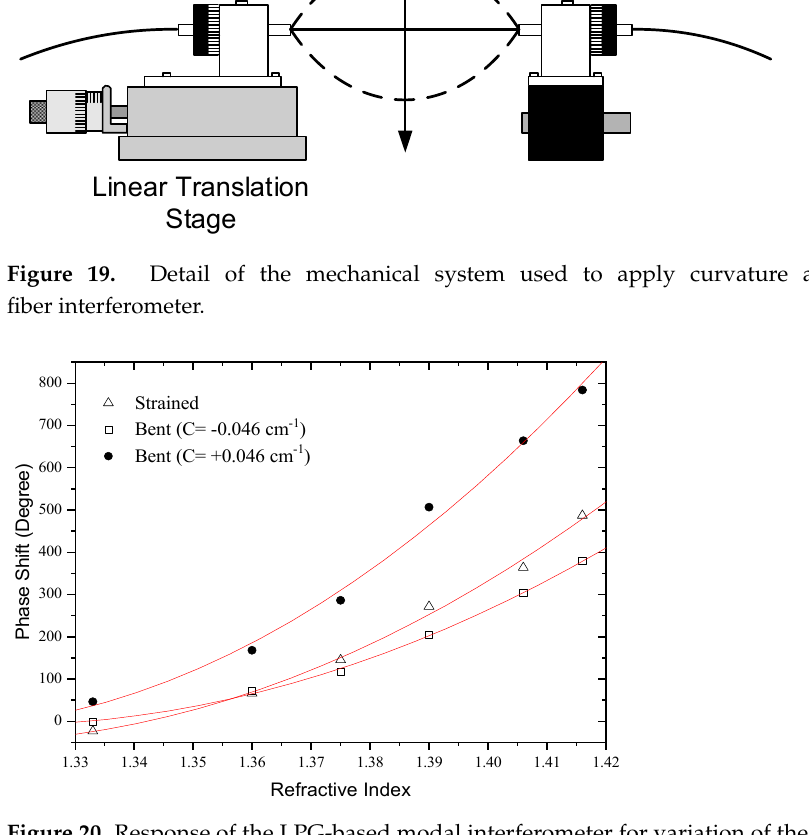
Figure 20. Response of the LPG-based modal interferometer for variation of the external medium refractive index when the fiber is straight and curved with values C o = ± 0.046 cm − 1